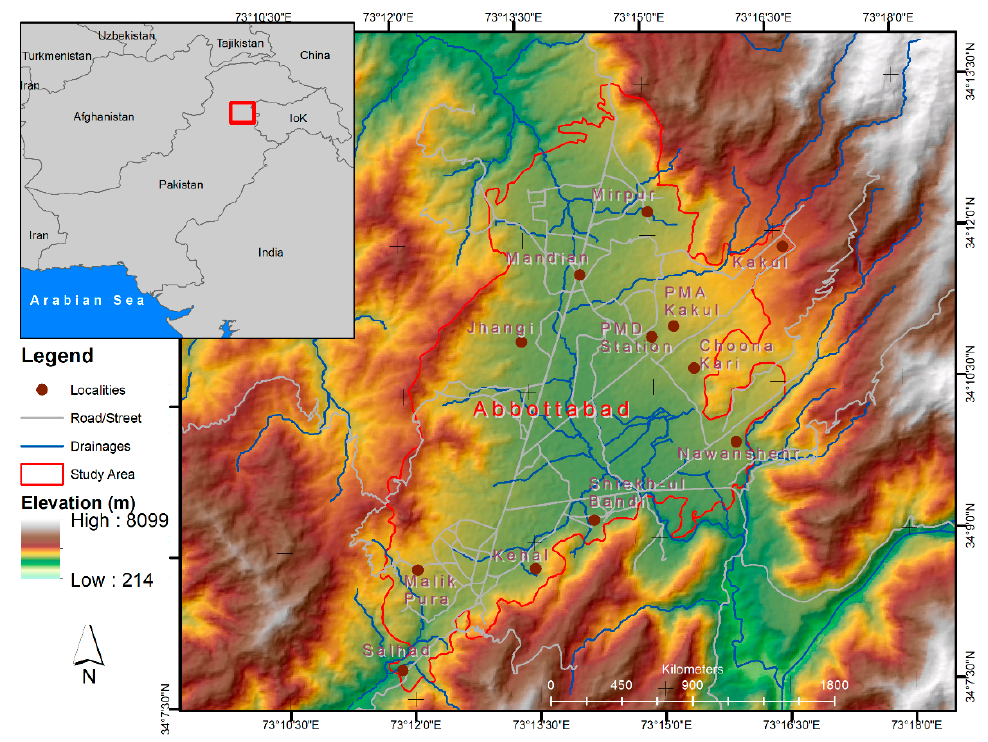
Figure 1. Location map of study area.